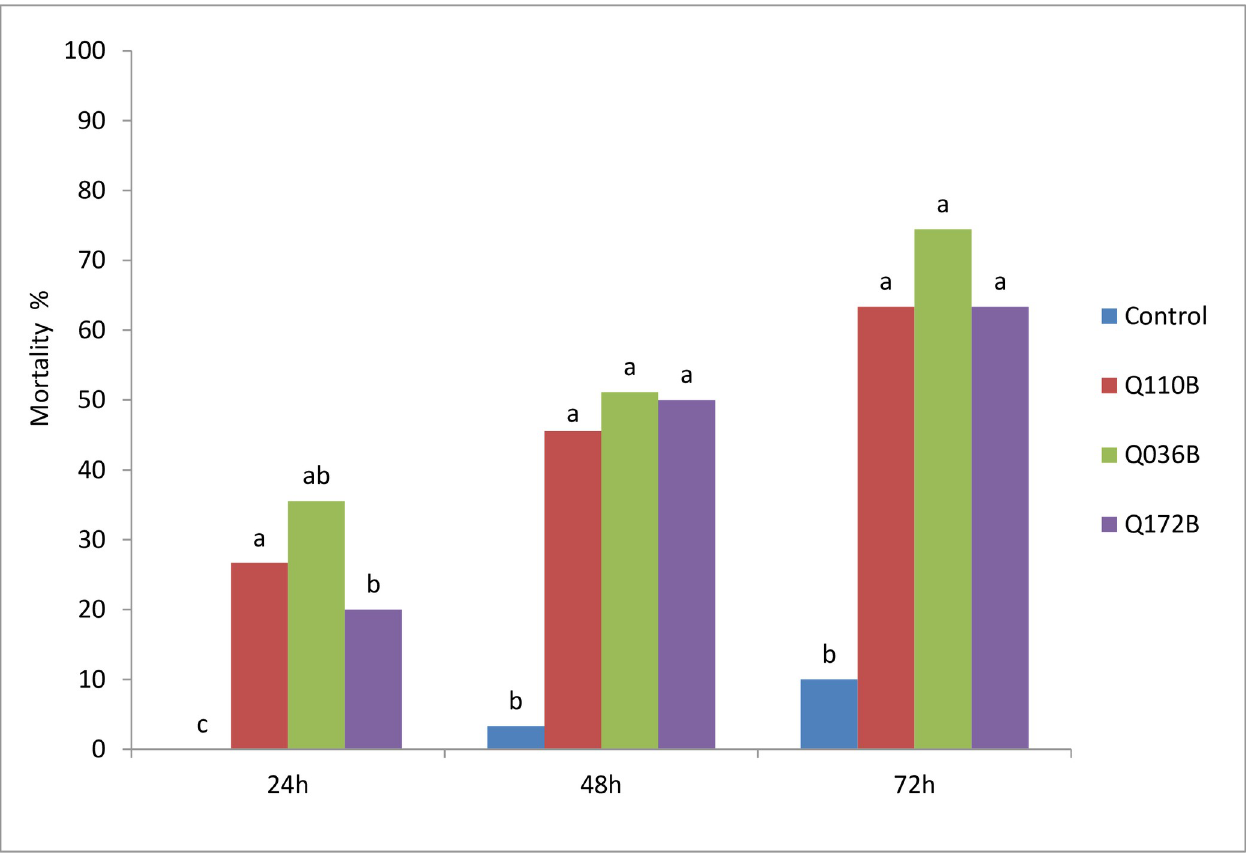
Fig 1. Mortality rate of B . tabaci adults over time as influenced by Pseudomonas isolates. Means with the same letter are not significantly according to the Newman–Keuls multiple range test ( α = 0.01).